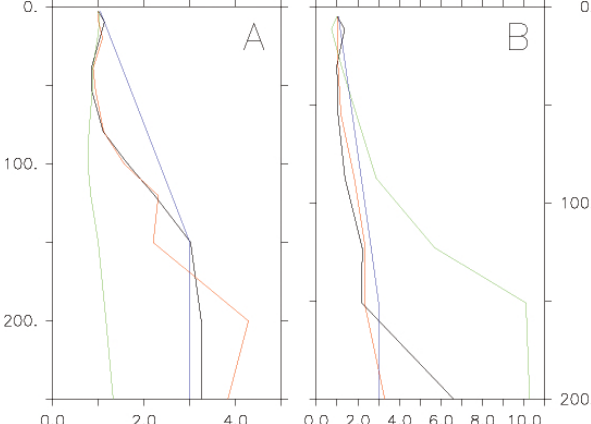
Figure 8. Cell size as a function of depth, normalised to cell size at the surface, (black) Prochlorococcus , (red) Synechococcus , (green) picoeukaryotes, (blue) exploratory conversion factor that increases up to a factor 3 below 150m depth. (A) At BATS, (B) in the Western Mediterranean (Almo-1 and